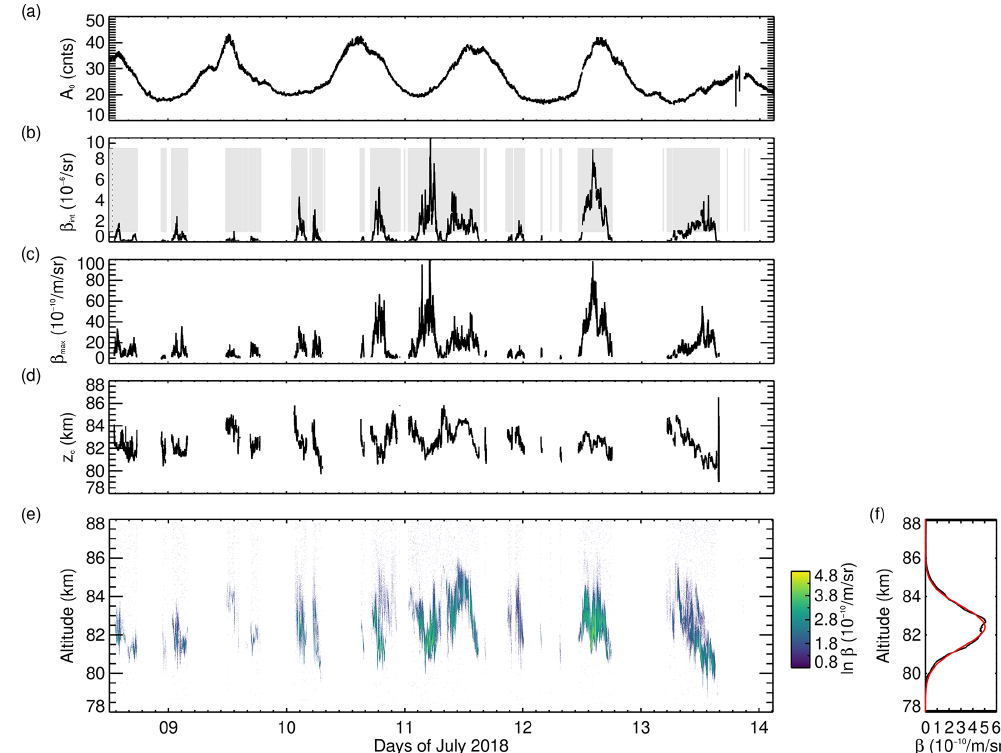
Figure 4. Evolution of PMC parameters during the 6d flight of PMC Turbo. (a) A 0 represents the background at 96–120km that is removed from the photon count profiles prior to the derivation of the volume backscatter coefficients. (b) Vertically integrated volume backscatter coefficient β int , with the light grey areas indicating times with finite β int for a better visual impression of PMC occurrence frequency. (c) Maximum volume backscatter coefficient β max . (d) Centroid altitude z c . (e) Time–altitude section of volume backscatter coefficients β . (f) Flight mean β (black line) as a function of altitude and a Gaussian fit (red line) with a mean of 82.43km and standard deviation of 1.08km. The resolution of the data is 20m and 10s.